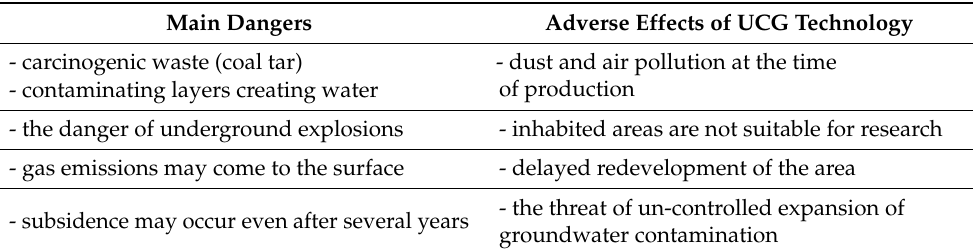
Table 1. Main dangers and adverse effects of UCG technology